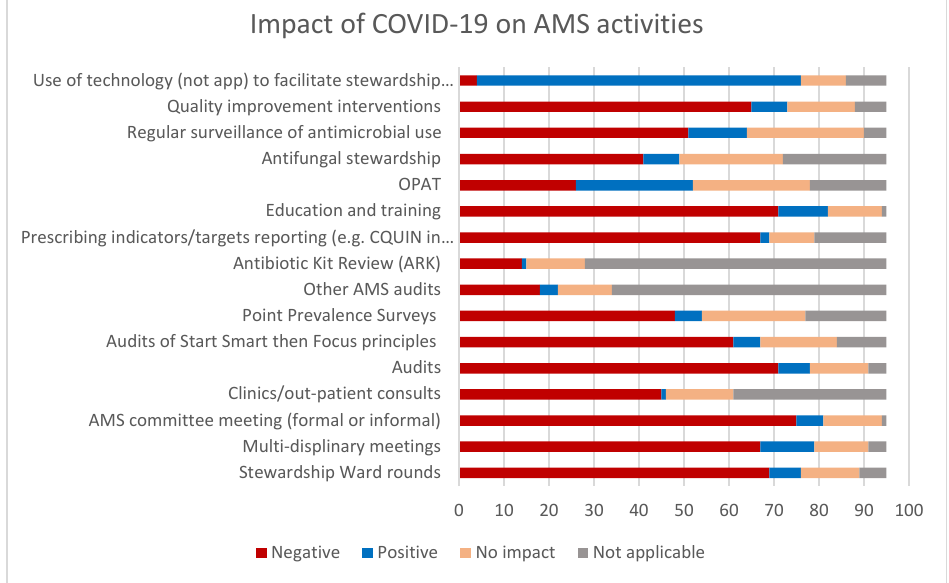
Figure 1. Impact of coronavirus 2019 (COVID-19) on antimicrobial stewardship (AMS) activities ( n = 95 survey respondents).